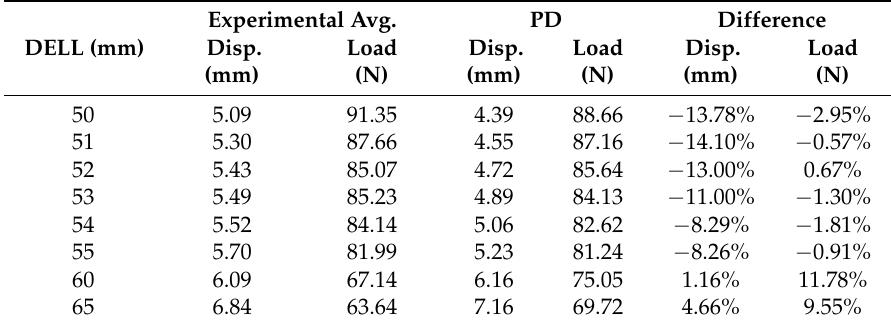
Table 3. Comparison between PD delamination growth with experimental average results (DELL: delamination